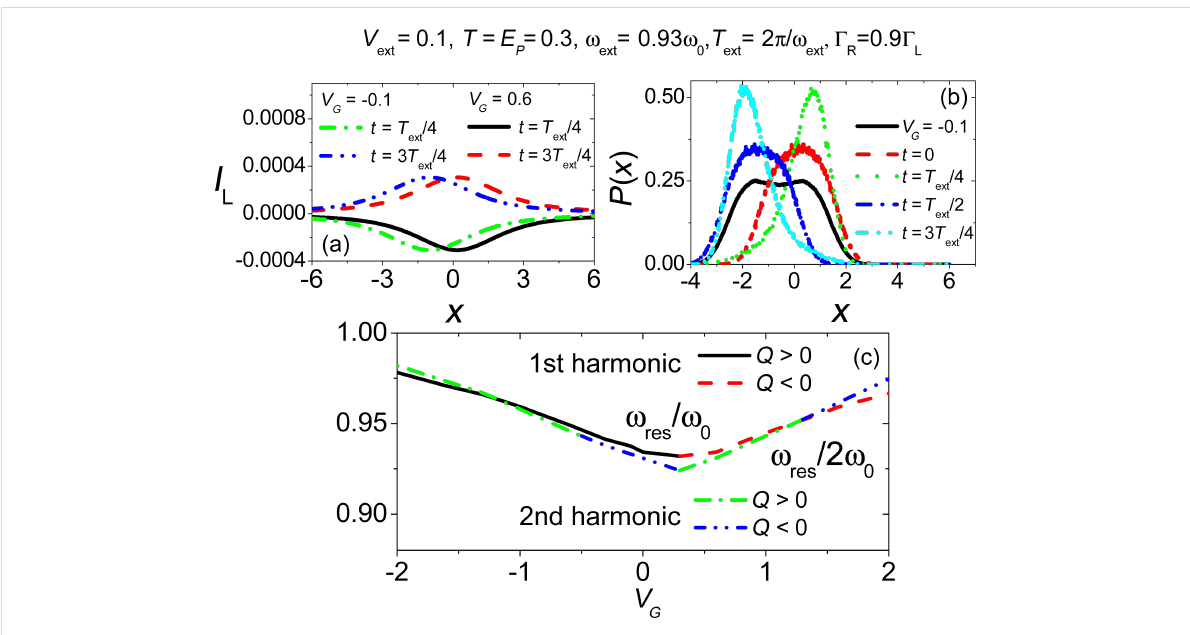
Figure 12: Single-parameter charge-pumping mechanism, and oscillator frequency as a function of the gate voltage. Panel (a): Left current I L as a function of oscillator position x for different times t and static gate voltages V G . Panel (b): Reduced position probability distribution P as a function of x for different times t at fixed static voltage V G . The time averaged distribution is in black line. Panel (c): Softening of the resonance frequency corre- sponding to the first and to the second harmonic as a function of the static gate voltage V G . Adapted and reproduced with permission from [79], copy- right 2013